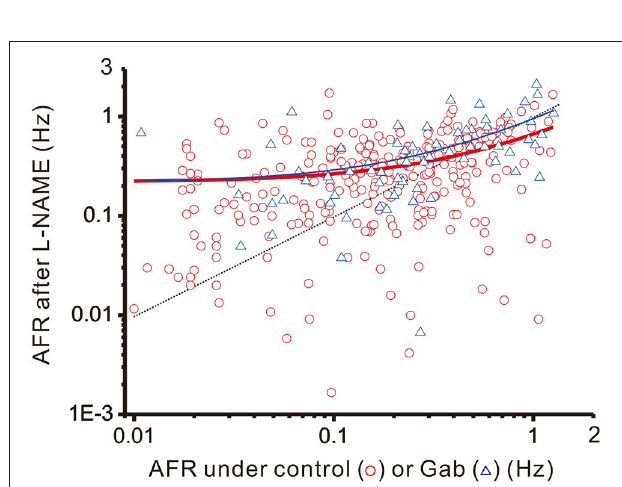
FIGURE 8 | Linear curve fitting for the data obtained from plotting the AFR after L-NAME applications against the AFR prior to L-NAME applications. The plot shows two series of data obtained from the experimental conditions with (blue triangles) or without (red circles) 20 µ M Gab pretreatments. Data were fitted by a simple arithmetic model as described in section Materials and Methods to determine the coefficient of step increment ( c s ) and the coefficient of fractional reduction ( c f ), as summarized in Table 1 . The red thick line depicts the curve fitted for the data without Gab pretreatments ( r 2 = 0.1571, n = 298, P < 0.00001) and the blue thin line depicts that with Gab pretreatments ( r 2 = 0.3292, n = 70, P < 0.00001). The data distributed near the black dashed line were the data not responsive to L-NAME applications. With Gab pretreatments, there was a significant drop of c f ( P < 0.05; see Table 1 ), leading to a slope increase of the fitted